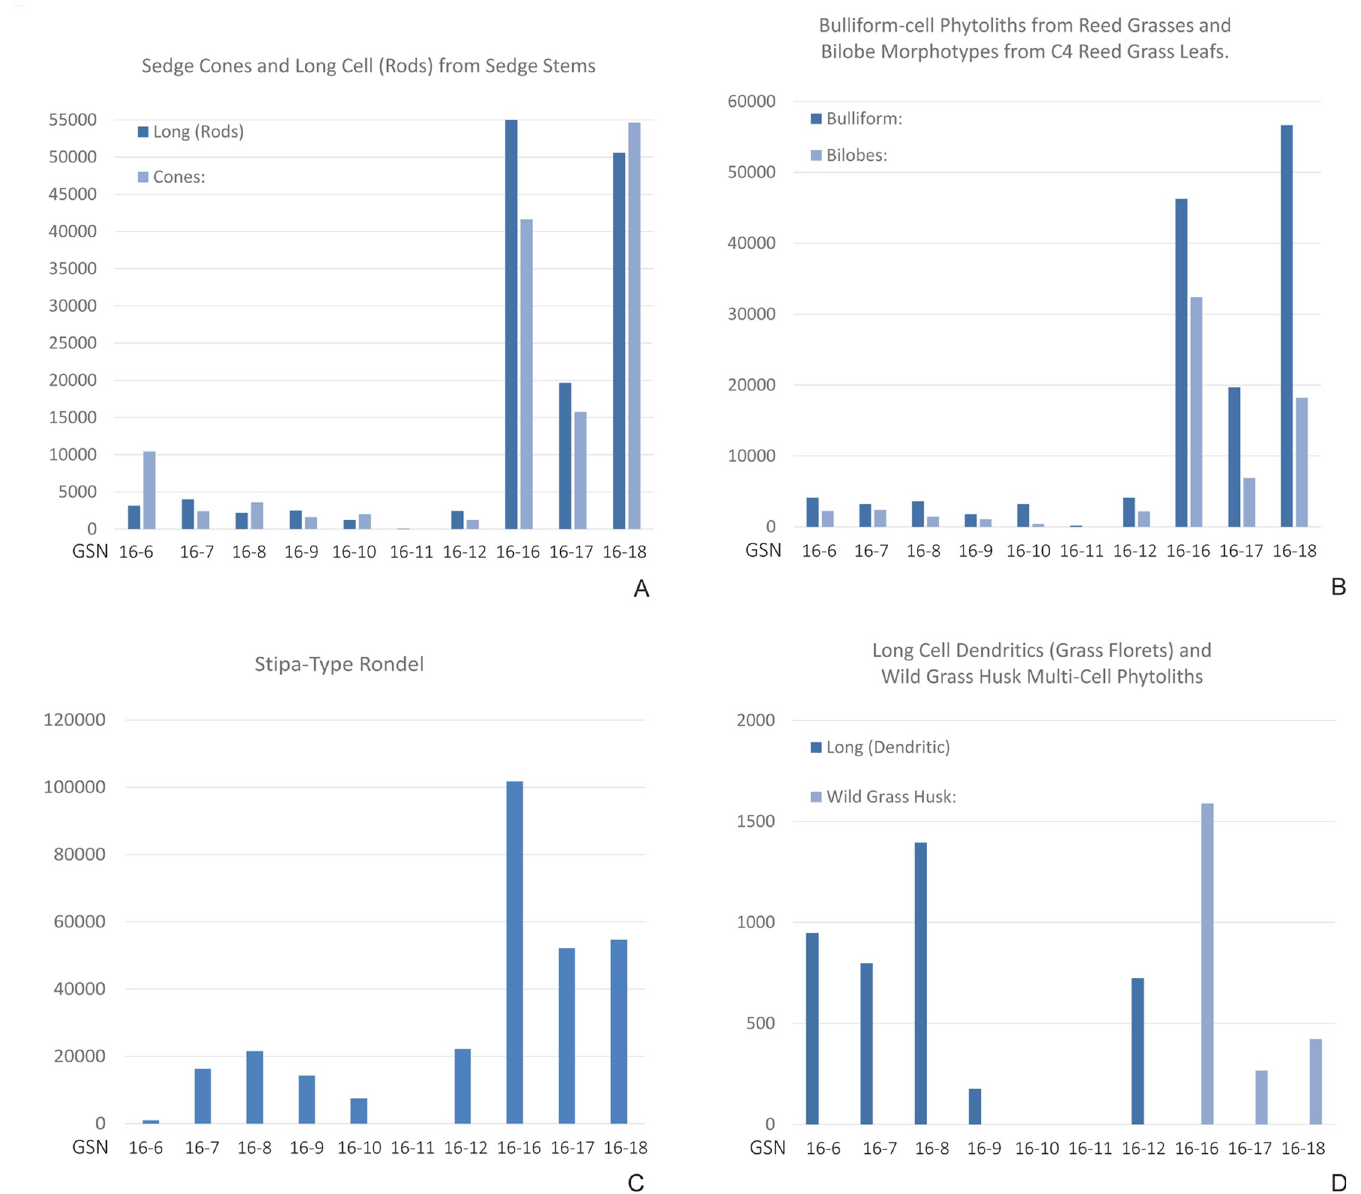
Fig 10. Visual comparison between numbers of sedge, reed, and grass phytoliths from each sample. Locus 1: 16–16, 16–17, 16–18. Locus 2: 16–6, 16–7, 16–8, 16–9, 16–10, 16–11, 16–12.